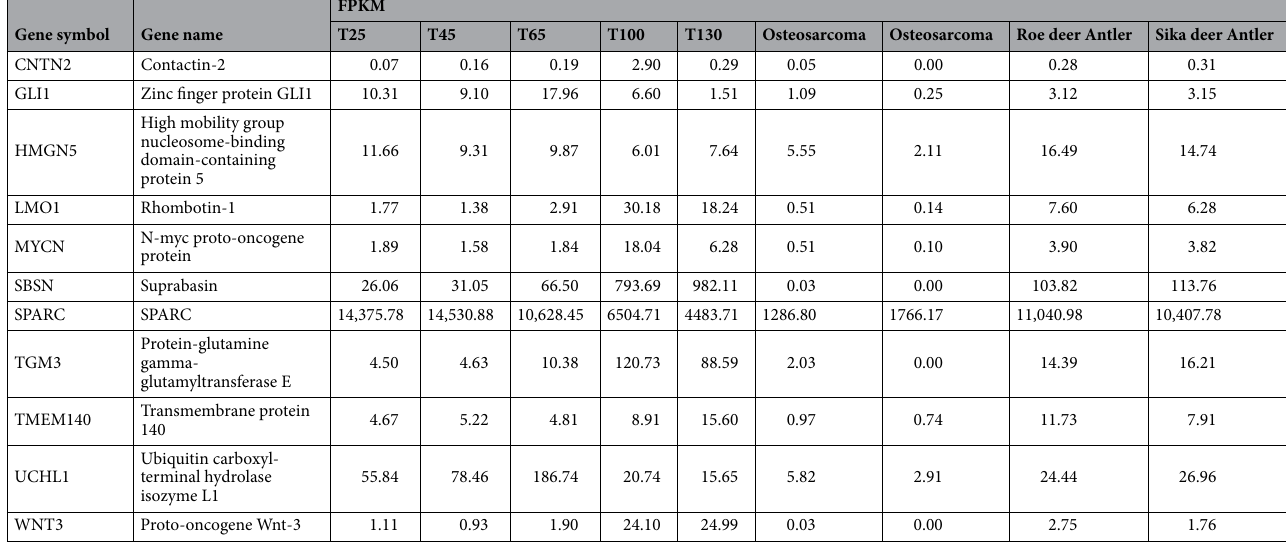
Table 4. 11 oncogenes associated with antler development.